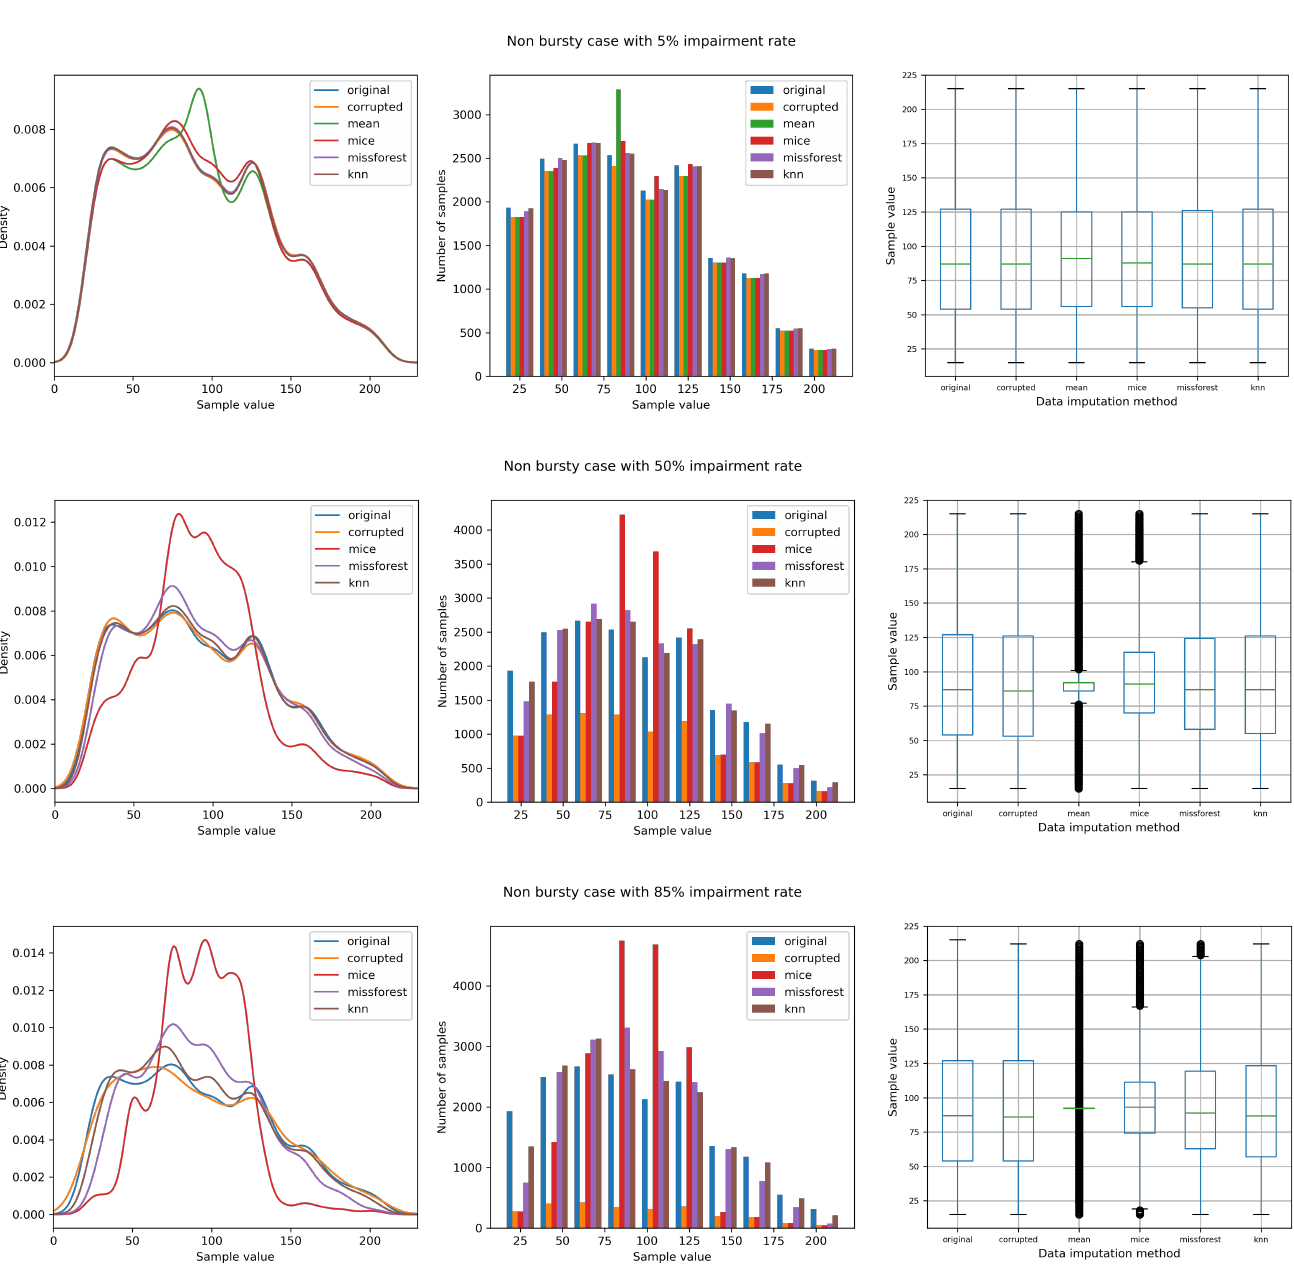
Figure 3. Non-bursty case comparison with 5%, 50%, and 85% impairment